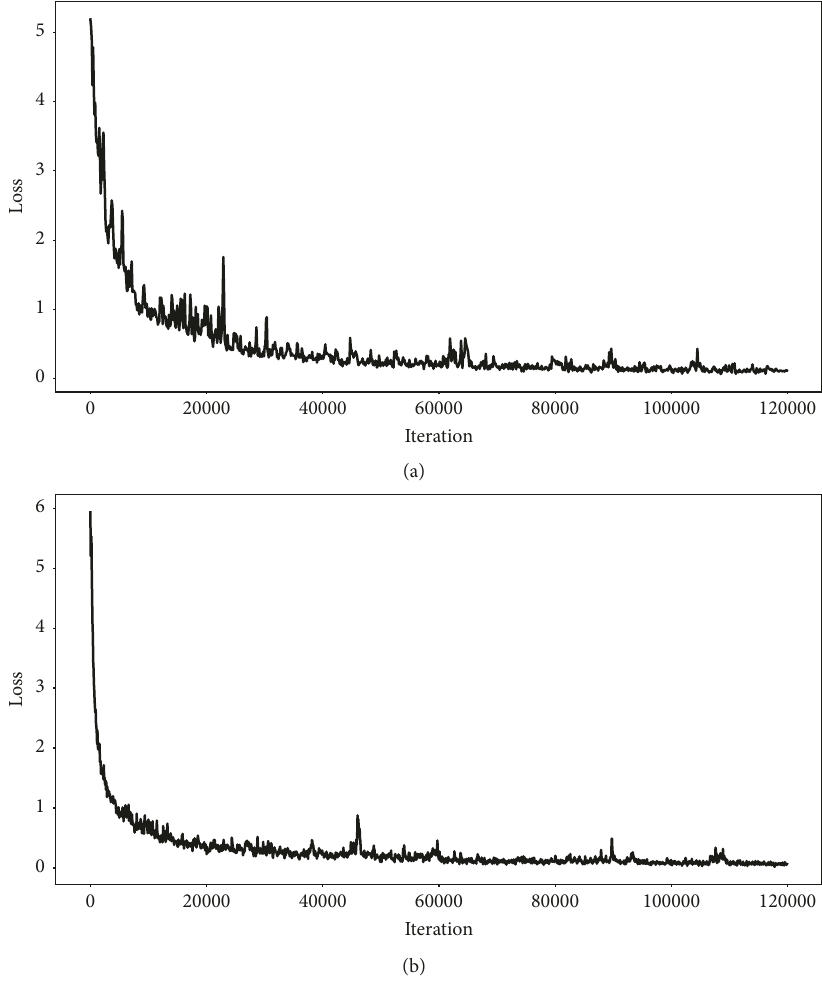
Figure 6: Relationship between loss and iteration. (a) VOC 2007. (b) VOC 2007 and 2012.